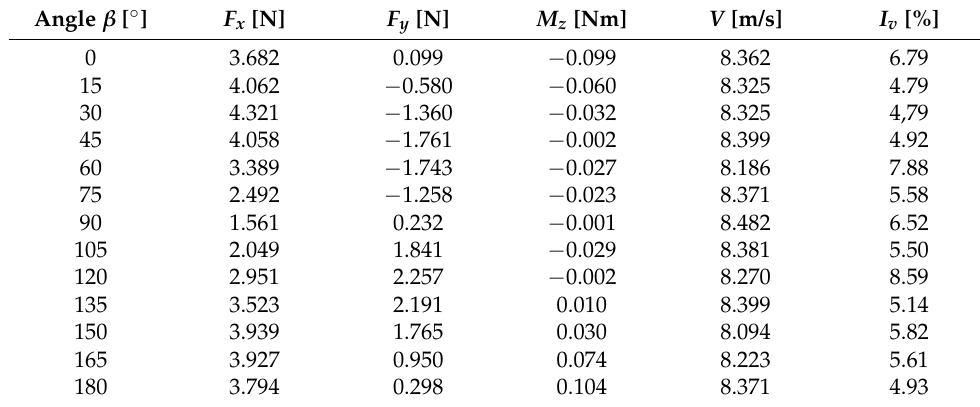
Table 2. Experimental results obtained for configuration 1.